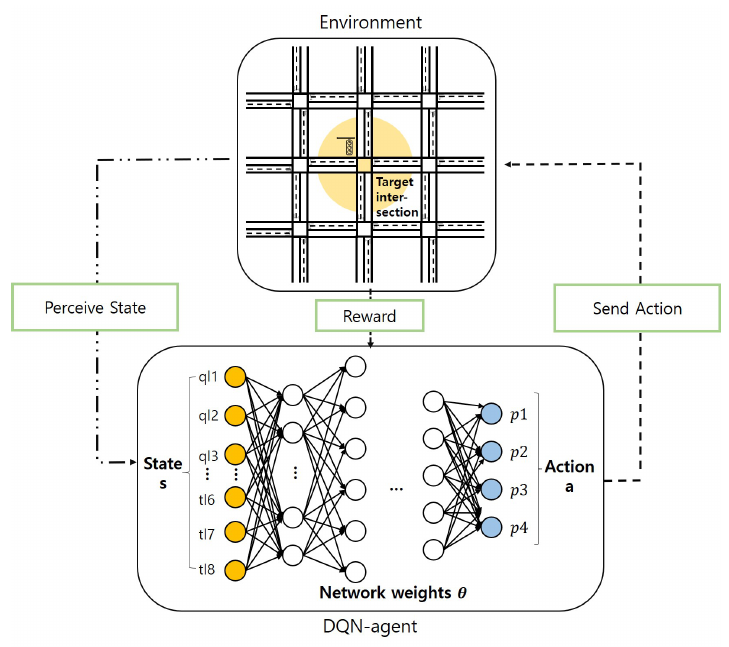
Figure 7. A framework of the proposed